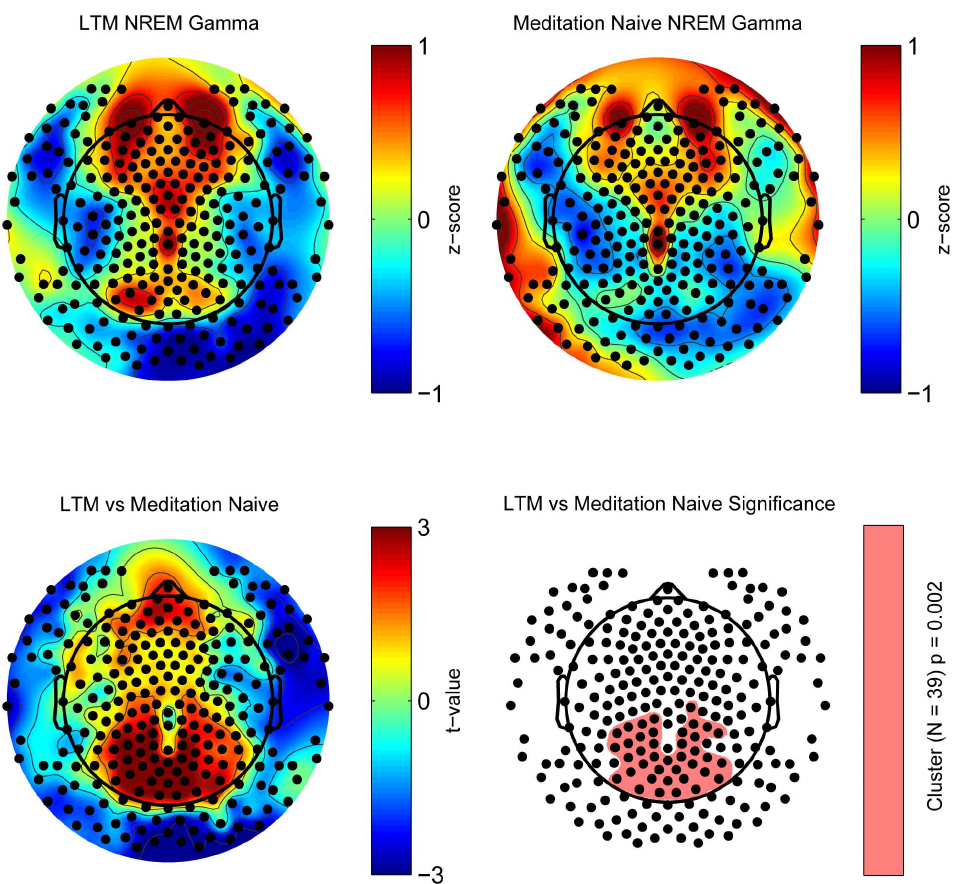
Figure 1. Long-term practitioners (LTM) had higher NREM gamma power (25–40 Hz) compared to meditation naives in a parietal- occipital region. As shown in topographic color plots (colorbar in m V 2 ), both groups had maximal EEG gamma power in frontal/prefrontal regions. Furthermore, LTM showed a 35% gamma power increase in a parietal-occipital region compared to meditation naives. The pink area in the white topographic plot depicts the parietal-occipital electrode cluster (N=39) with a significant power increase in LTM (p=0.002, Statistical non Parametric Mapping, SnPM).